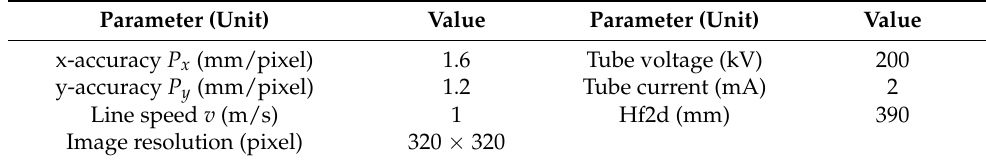
Figure 2. Diagrammatic sketch of DE-XRT sorting system. Table 2. Experimental